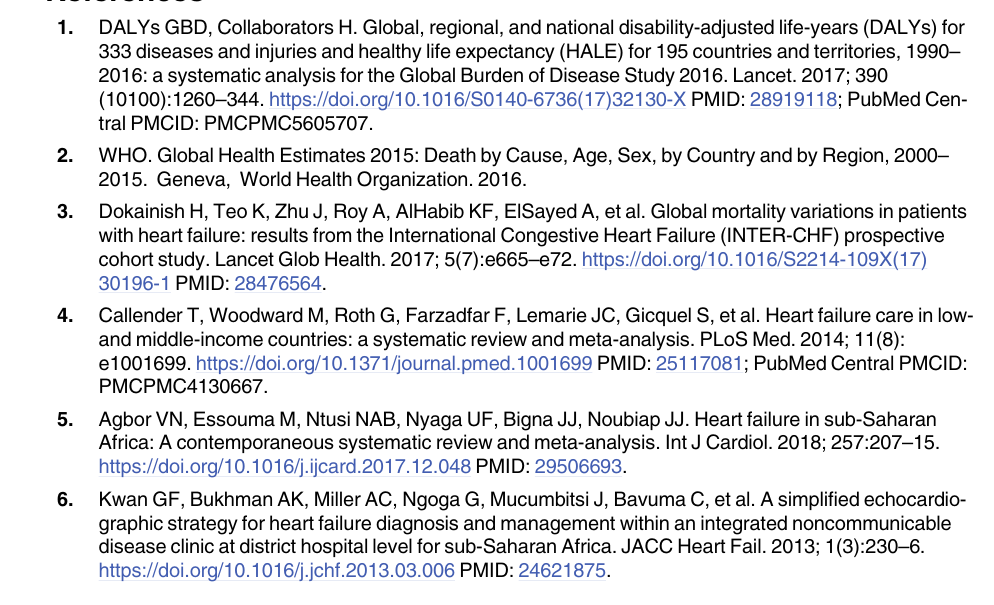
S3 Table. Dataset adults. S4 Table. Dataset,